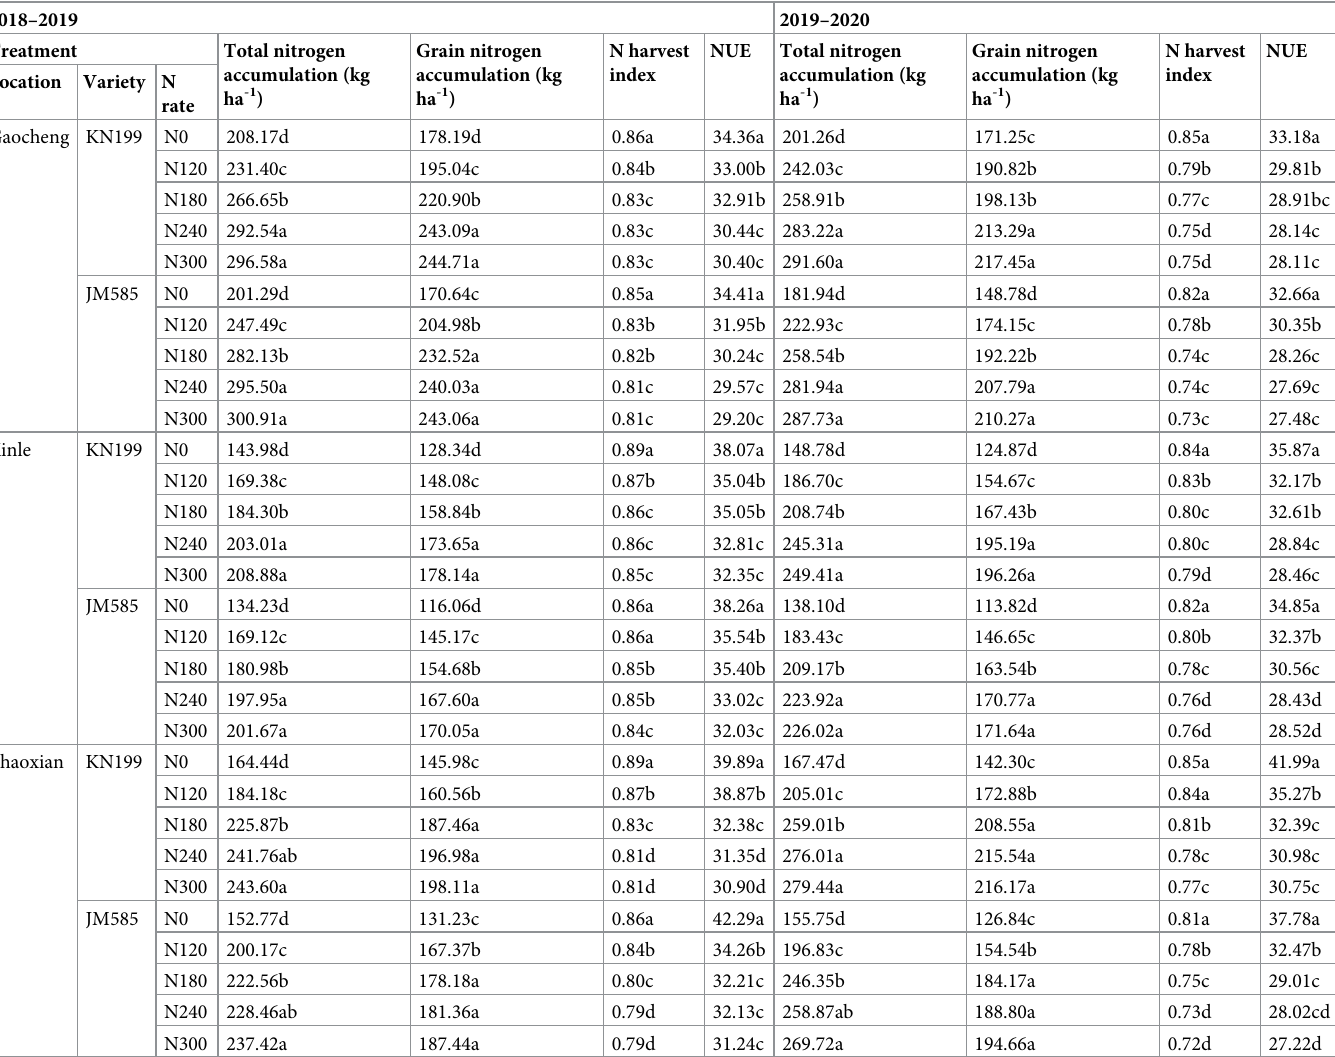
Table 3. Nitrogen accumulation at maturity of different winter wheat varieties under different nitrogen fertilization rates in three experimental sites during 2018– 2020